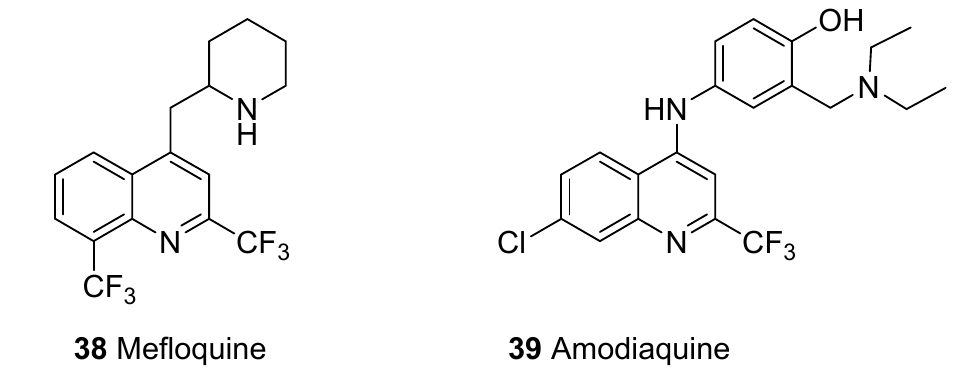
Figure 12. Synthetic antimalarial drugs. Mefloquine and amodiaquine are included in WHO list of essential medicines. (https://www.who.int/medicines/publications/essentialmedicines/en/, accessed on 1 April 2021).